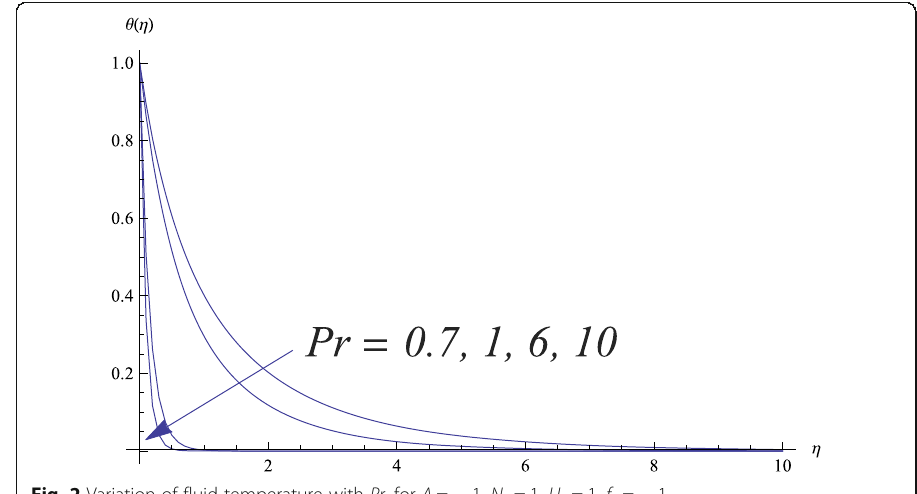
Fig. 2 Variation of fluid temperature with Pr , for A = − 1, N R = 1, U 0 = 1, f 0 = − 1